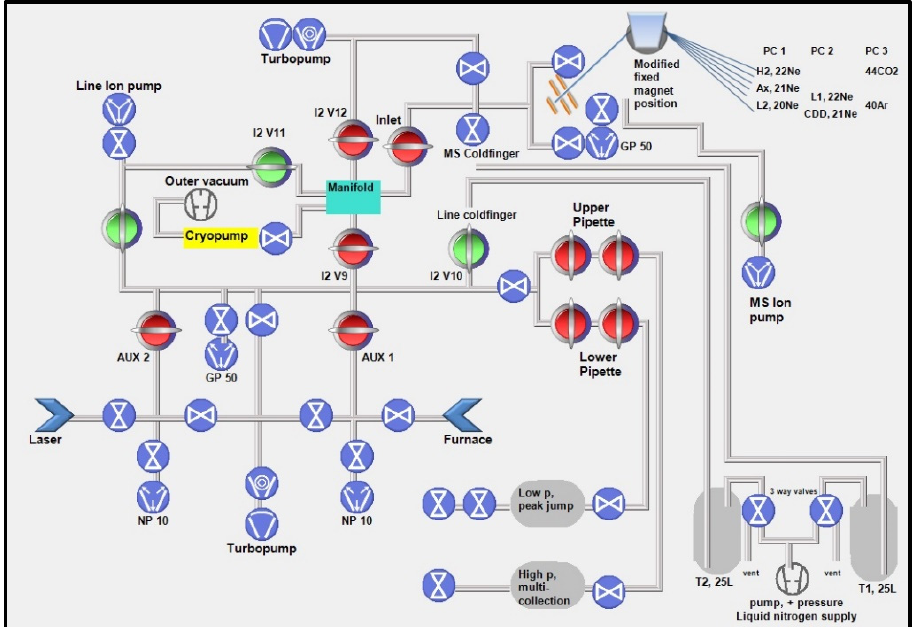
Figure 1. Schematic picture of the fully automatized Thermo Fisher ARGUS VI mass spectrometer and preparation system in SUERC. Two 2L air reservoirs, each equipped with a 0.1 cm 3 gas pipette, provided the means for calibration. The magnet position allowed multi collecting of Ne isotopes. PC1: (H2: 22 Ne—Ax: 21 Ne—L2: 20 Ne). PC2: (L1: 22 Ne—CDD: 21 Ne). PC3: (H2: 44 CO 2 —L2: 40 Ar). Blue valve: manual. Green: pneumatically actuated, open. Red: pneumatically actuated, closed. PC: peak coincidence.